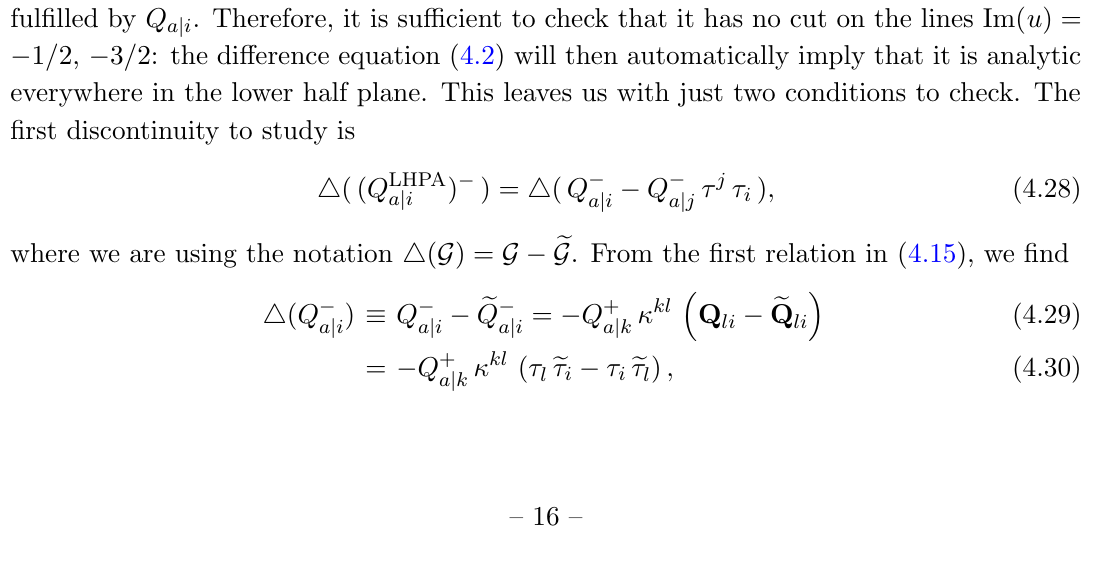
JHEP09(2017)140